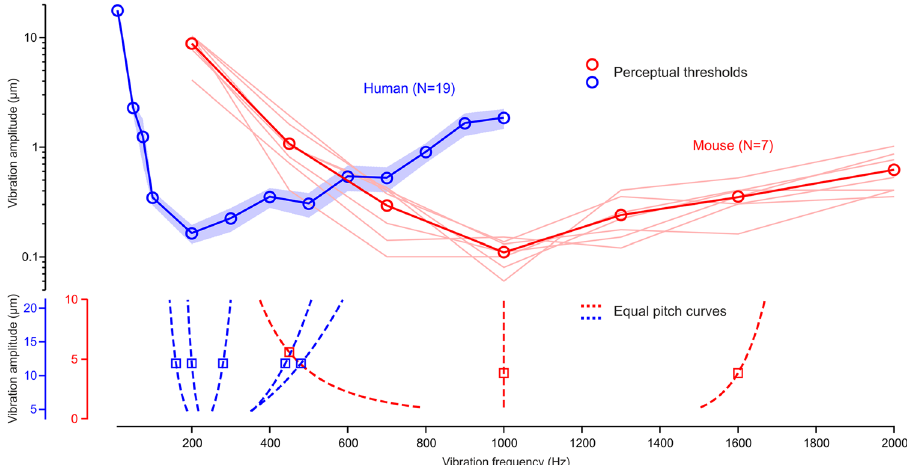
Fig. 3 V-shaped perceptual sensitivity curves. Amplitude thresholds as a function of vibration frequency for mouse (shaded lines: individual mice, symbols: mean) and human (mean ± s.e.m.). The equal-pitch curves for all tested center/reference frequencies are replotted in the bottom panel illustrating that vibratory pitch perception shifts, with increases in amplitude, toward the frequency of highest vibrotactile sensitivity in both mouse (red) and human